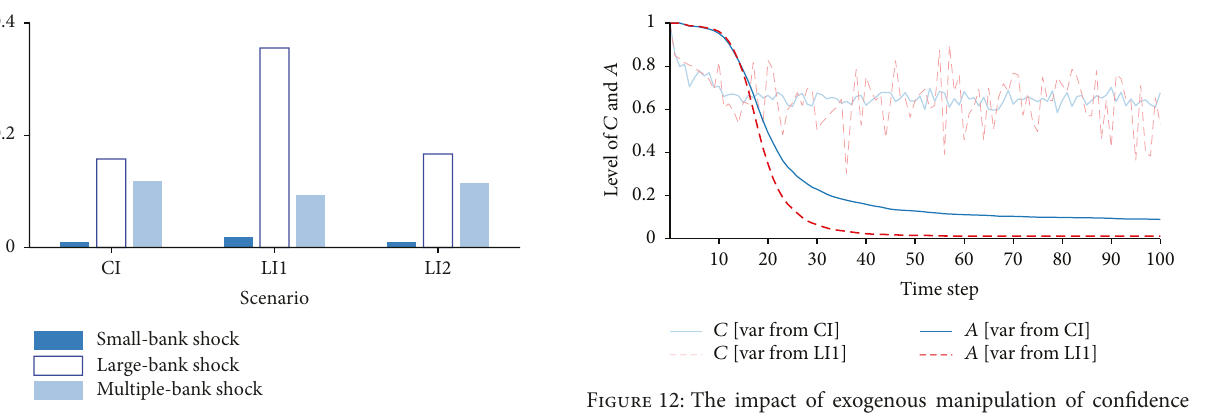
Figure 11: Standard deviation of con fi dence across complete information (CI) and local information (LI) scenarios and three shock treatments: to a small bank, a large bank, and multiple small banks. The LI1 scenario in fl ates standard deviations of con fi dence in both single-bank-shock treatments. The multiple- bank treatment involves a number of small banks whose total assets amount to the assets of a single large bank. LI1 and LI2 =scenarios in which a bank has access only to information from banks up to distance 1 and 2, respectively (Figure 16 in Appendix A displays all scenarios).